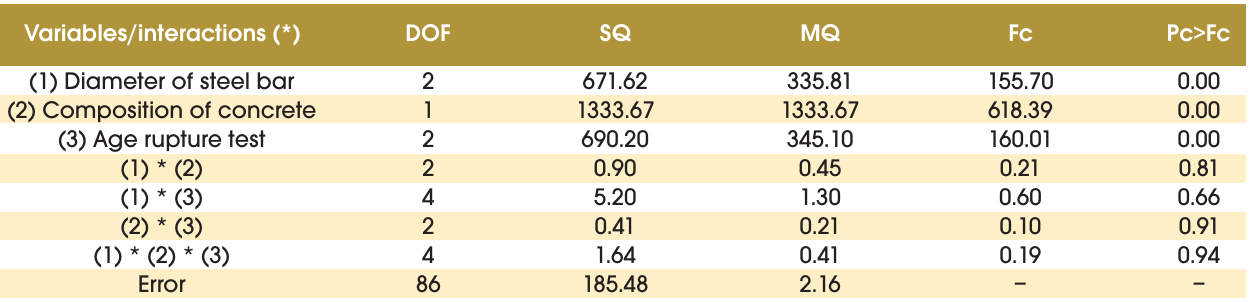
Table 5 – Analysis of variance (ANOVA) was performed on the results of the POT